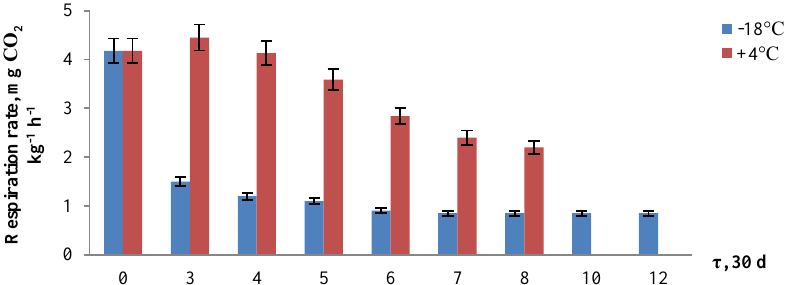
Fig. 1. Dates respiration rate during storage at +4 °C and −18 °С. Error bars here and after show the relative errors. According to Fig. 1, during the storage process of dates at +4 °C, the respiration rate decreased 2.1 times, reaching its minimum after 240 d. At −18 °C, during 120 d of storage, respiration rate decreased 3.4 times, and then it remained